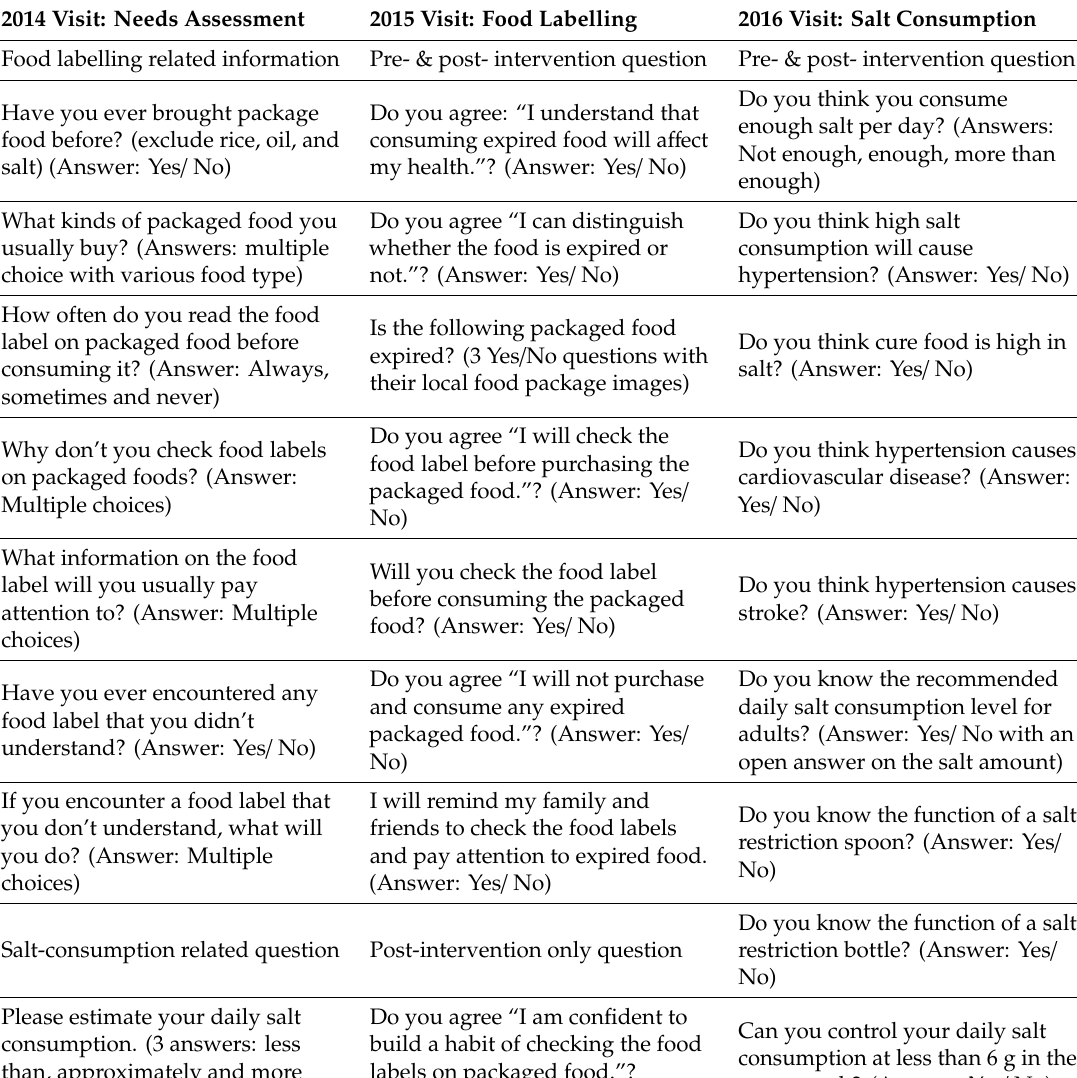
Table 1. Questions used in assessing food labelling and salt consumption awareness, attitude and behaviour in the visits (2014, 2015 &